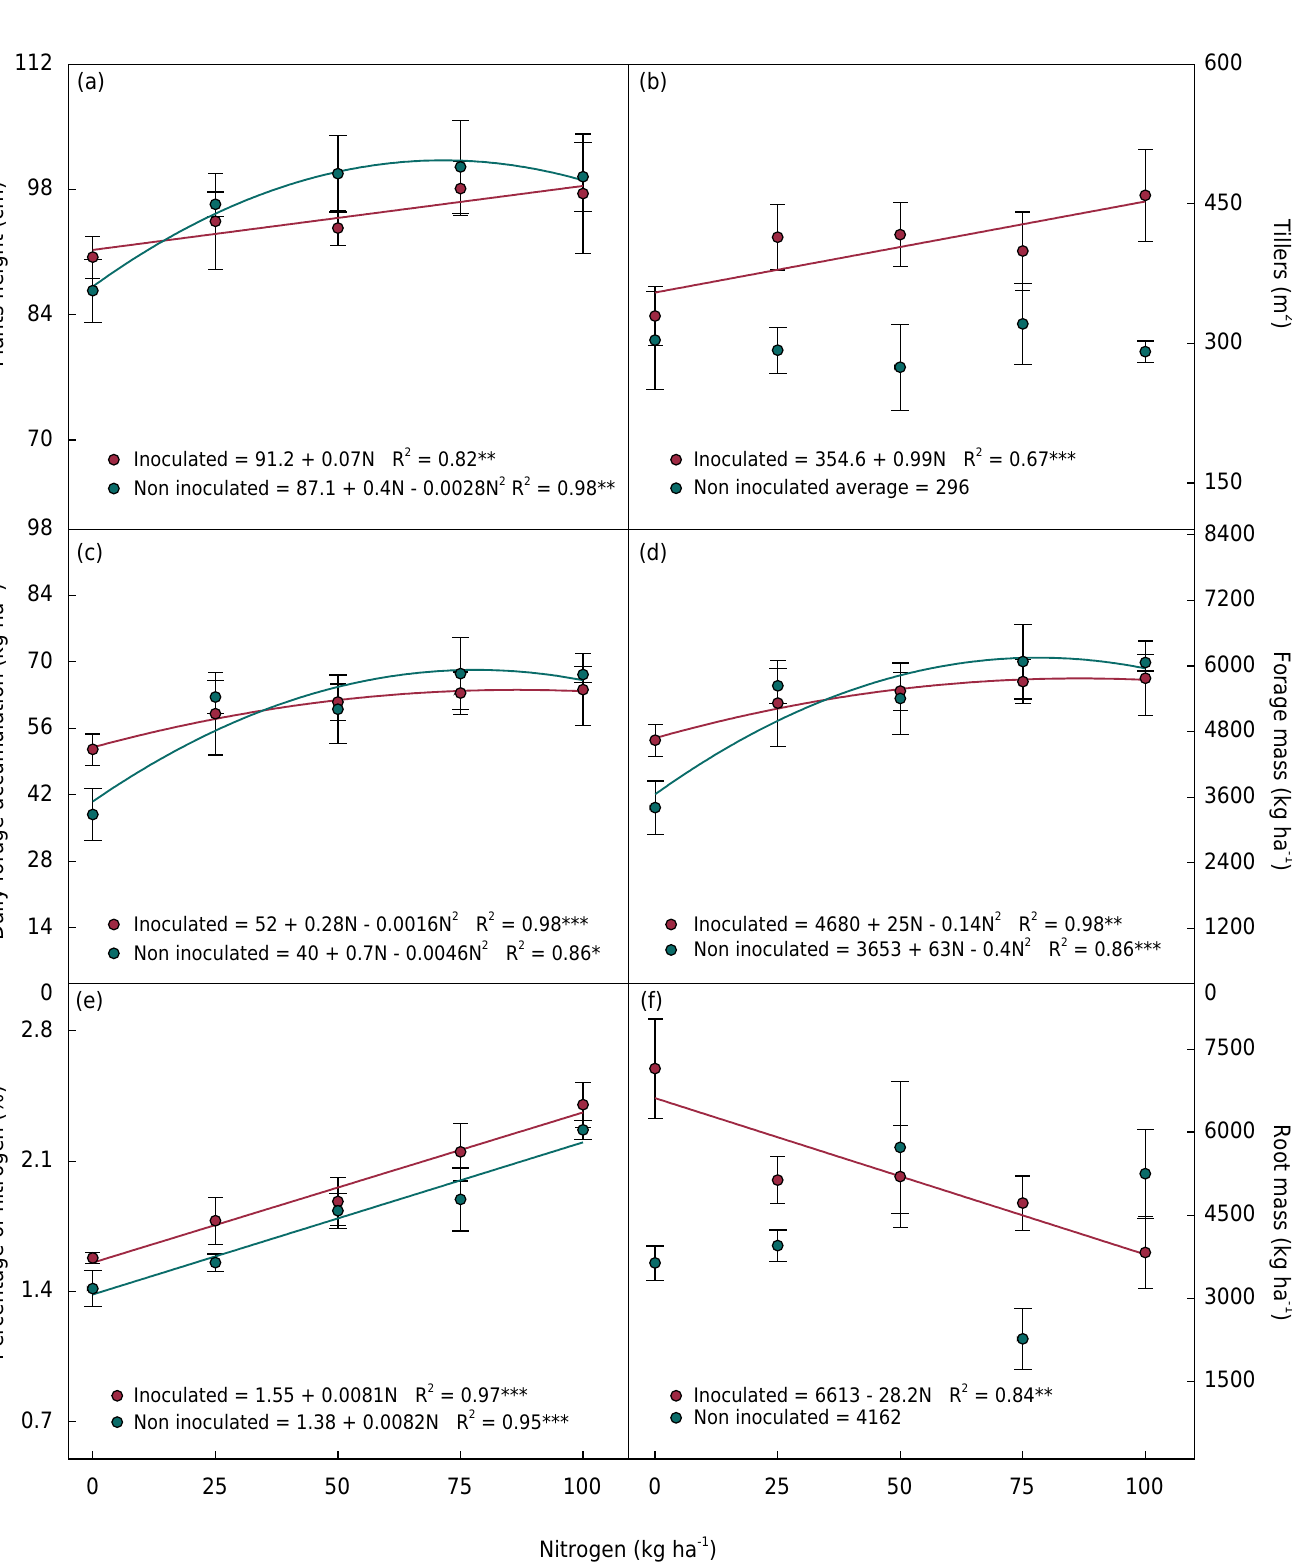
Total forage production (forage mass) presented an adjustment to the quadratic model, regardless of the inoculation (Figure 4d). For inoculated plants, there was production of 5,796 kg ha -1 at the maximum efficient dose of 83 kg ha -1 of N. Non-inoculated plants had a production of 6,213 kg ha -1 at the maximum efficient dose of 80 kg ha -1 of N.